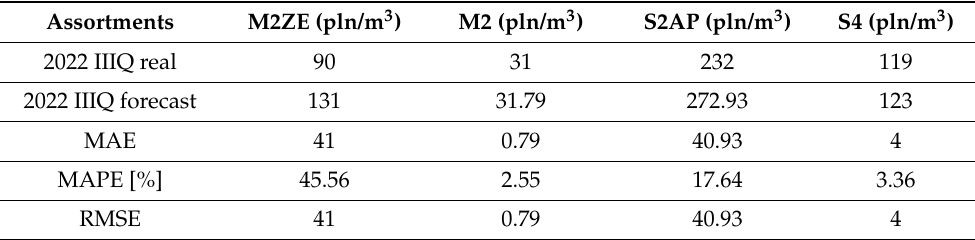
Table 5. MAE, MAPE, RMSE results for Q3 2022. Source: Own elaboration based on data obtained from the State Forests IT System